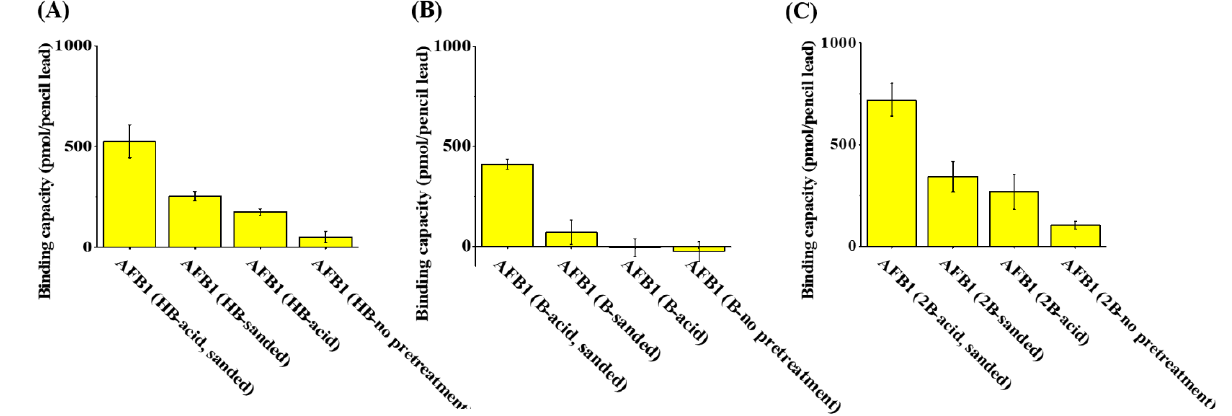
Figure 3. Examination of the binding capacity of types ( A ) HB, ( B ) B, and ( C ) 2B pencil leads against AFB1.